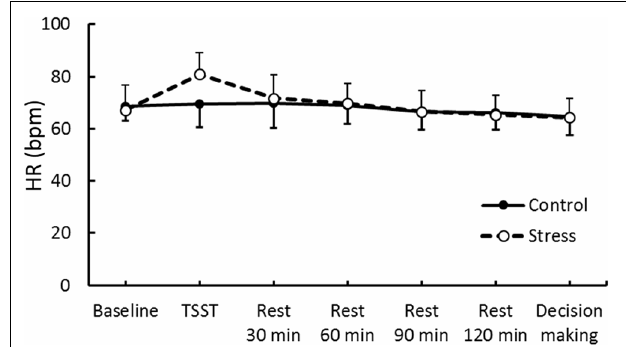
FIGURE 4 | Heart rate (HR) through experimental sessions in each group. Error bars indicate standard errors of mean.